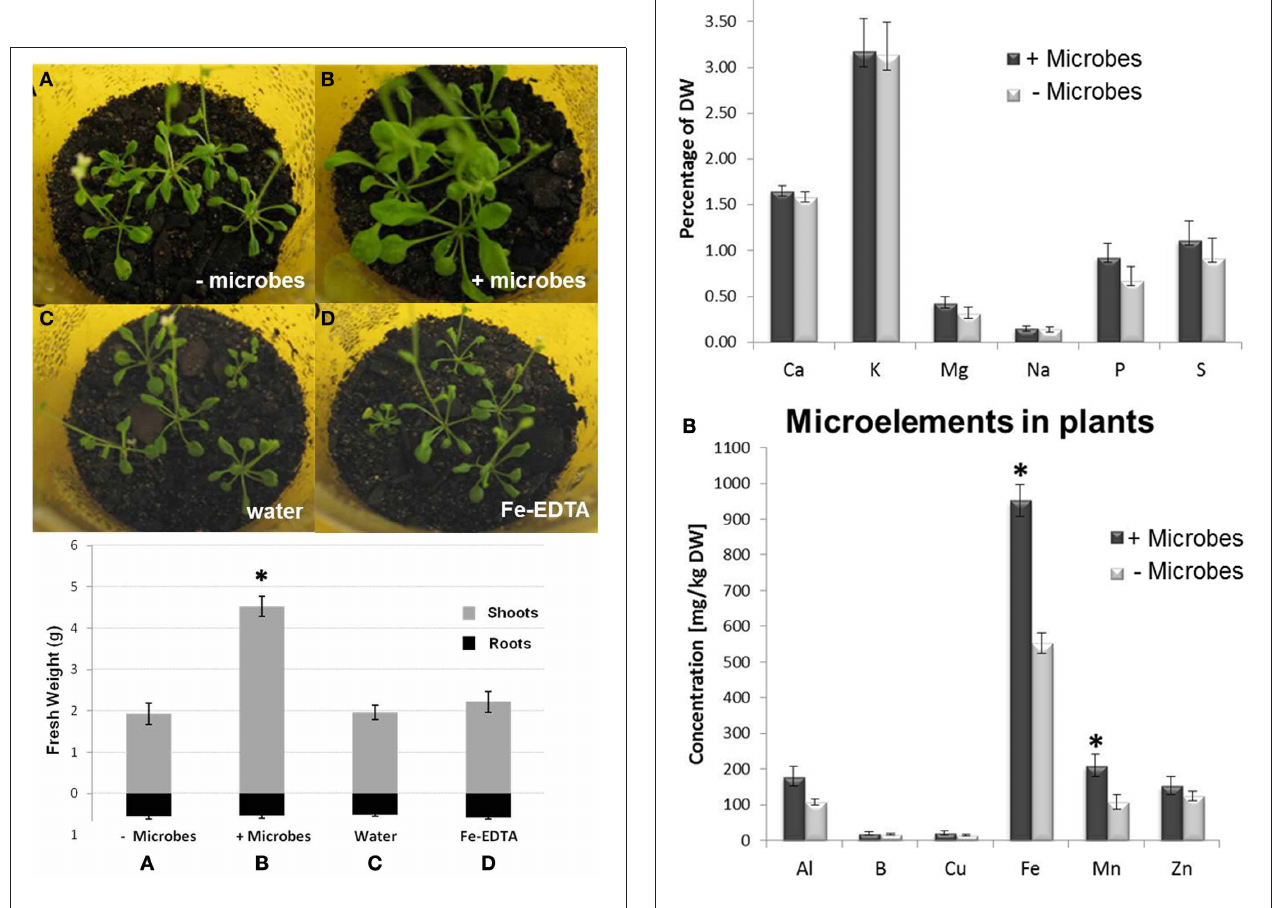
FIGURE 1 | Photographs of shoots and fresh weights of shoots and roots of Arabidopsis plants grown in sterile soil that was inoculated either with filter-sterilized soil extract (A; − microbes), non-sterile soil extract (B; + microbes), water (C) or Fe-EDTA (D). Bars represent mean values ± SE from three biological replicates (50 pooled plants/replicate). The asterisk indicates a statistically significant difference ( P < 0 . 05).